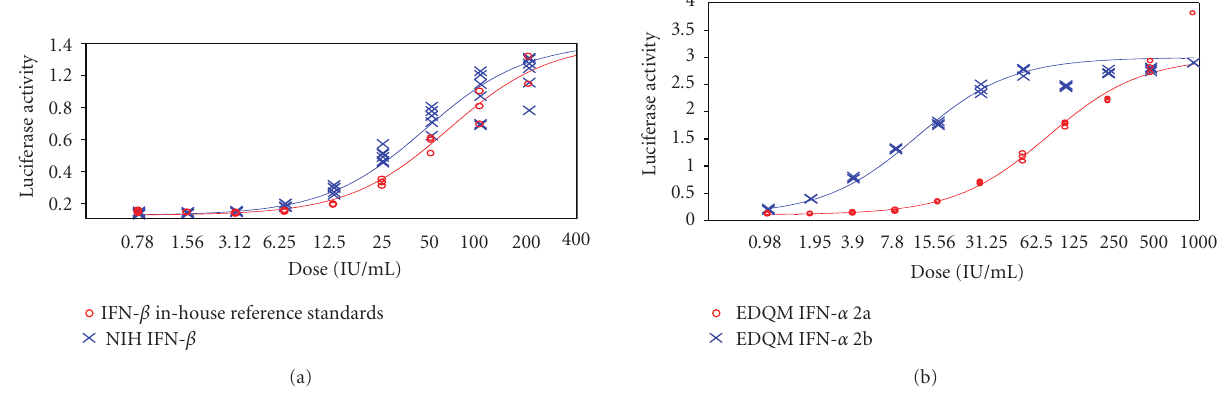
Figure 1: HEK293-ISRE-Luc cell line responses to treatment with various types of interferons. Panel (a) represents dose response curve obtained with IFN- β . Panel (b) represents dose response curve obtained with IFN- α . The assay was performed as described in “Section 2”. The cells were treated with type I IFN, followed by the analyses of luciferase activity. As expected, although IFN- α and IFN- β are both type I IFNs that drive the ISRE, the signalling pathway used is slightly di ff erent and thus we obtain a di ff erent dose response curve.